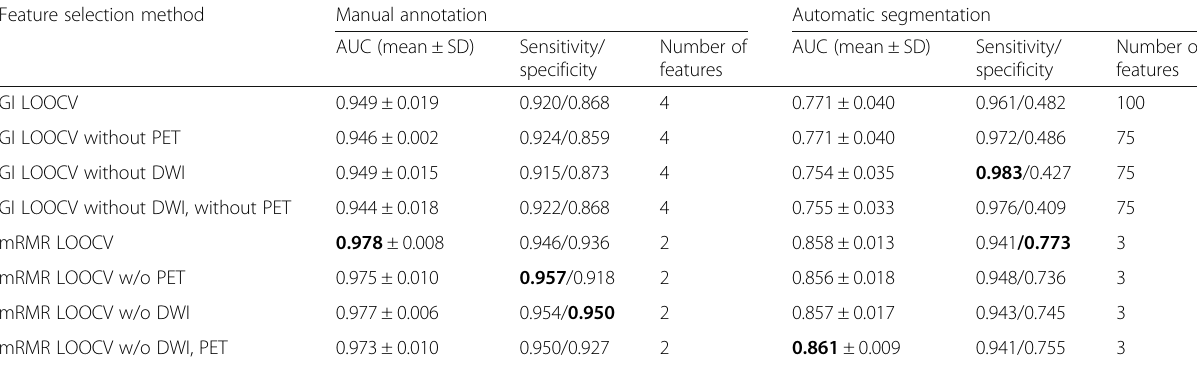
Table 5 Classification results for differentiation of malignant and benign lesions for manually annotated lesions and automatic segmented lesions using automatic feature selection